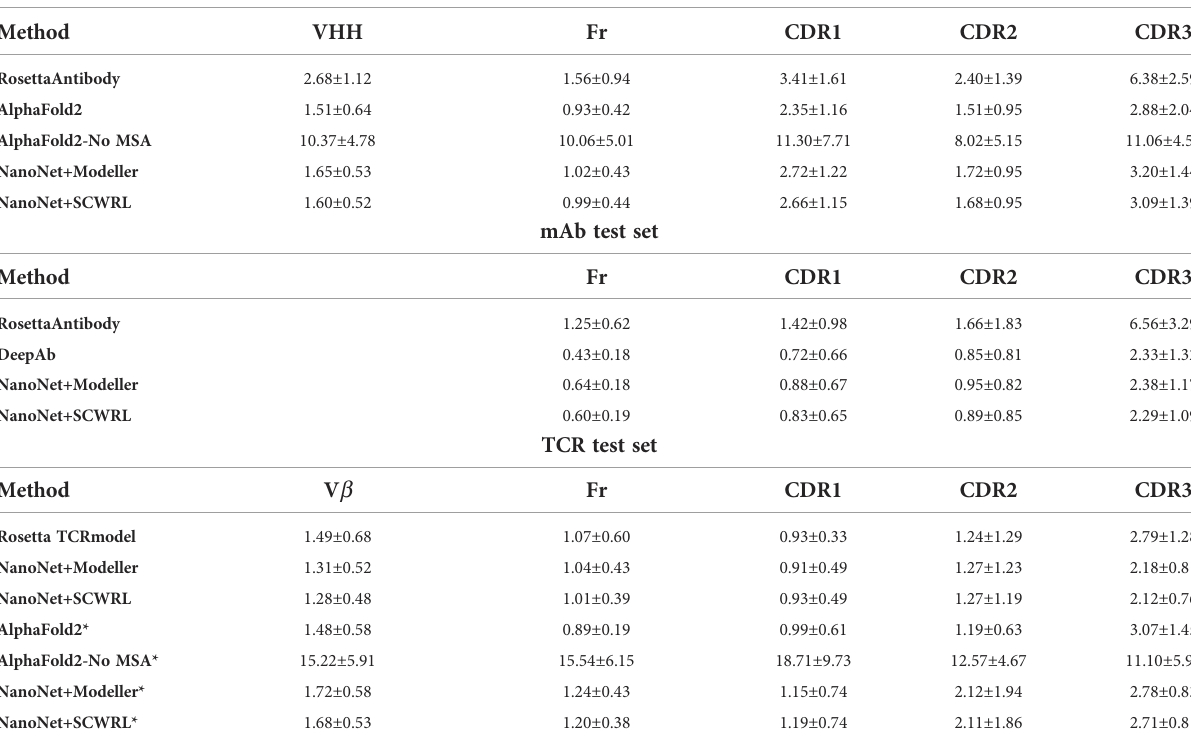
TABLE 1 Summary of mean RMSDs (Å) for the different test